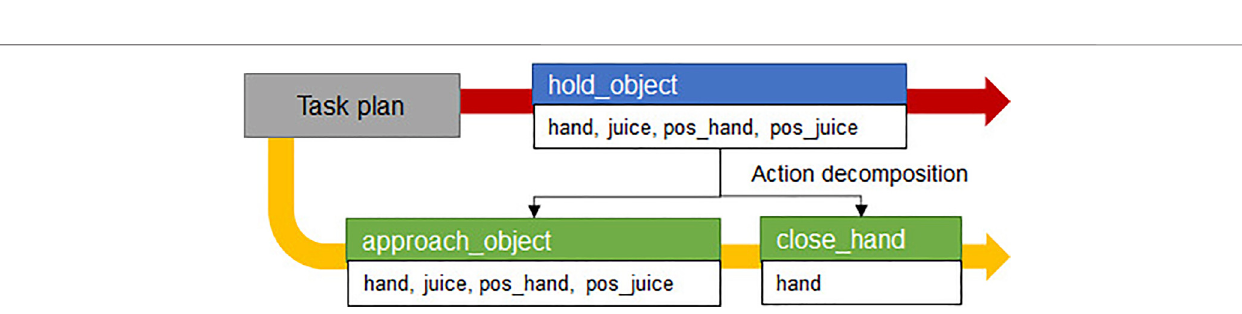
Frontiers in Robotics and AI |